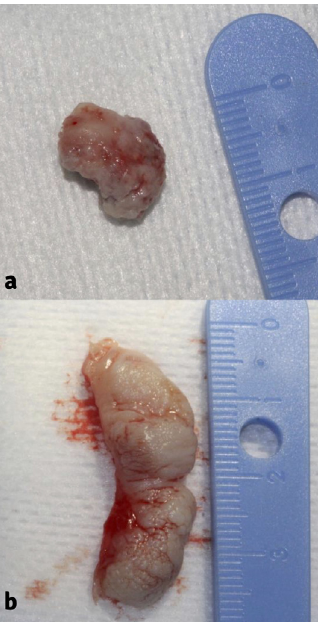
Fig. 5. Operative samples. a: osseous, 1.5 (cid:3) 1cm. b: